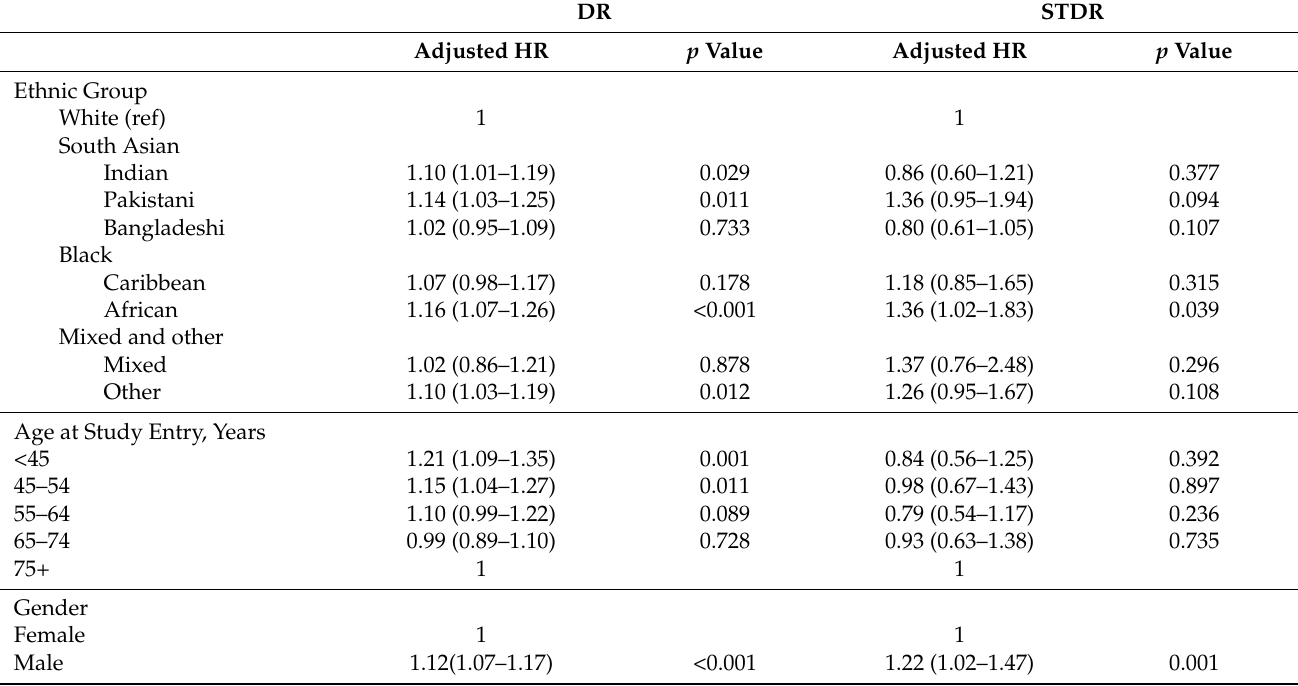
Table 4. Multivariable Cox regression analysis of outcome measures in newly diagnosed diabetes—Newly diagnosed T2DM Cases. DR STDR Adjusted HR p Value Adjusted